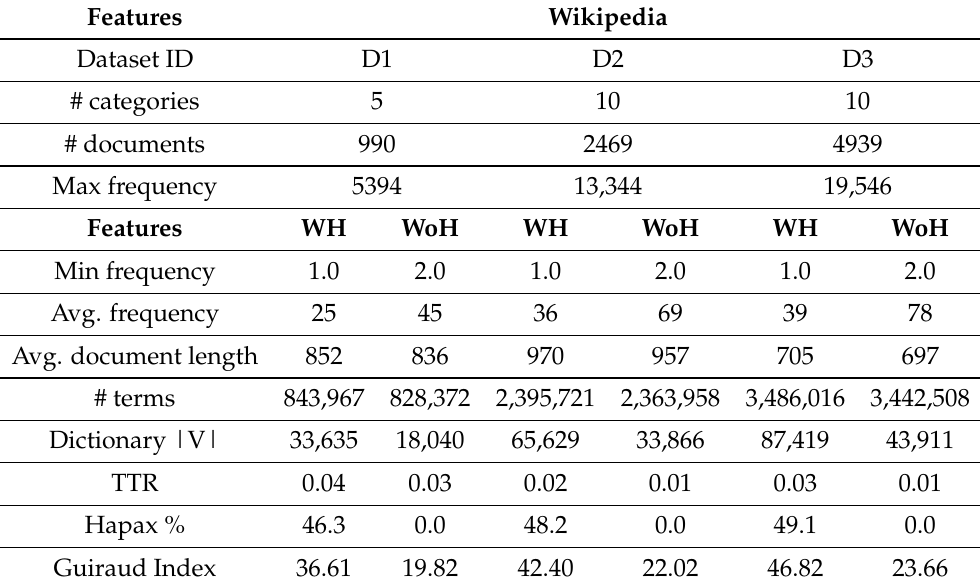
Table 2. Statistical features for the Wikipedia collections.